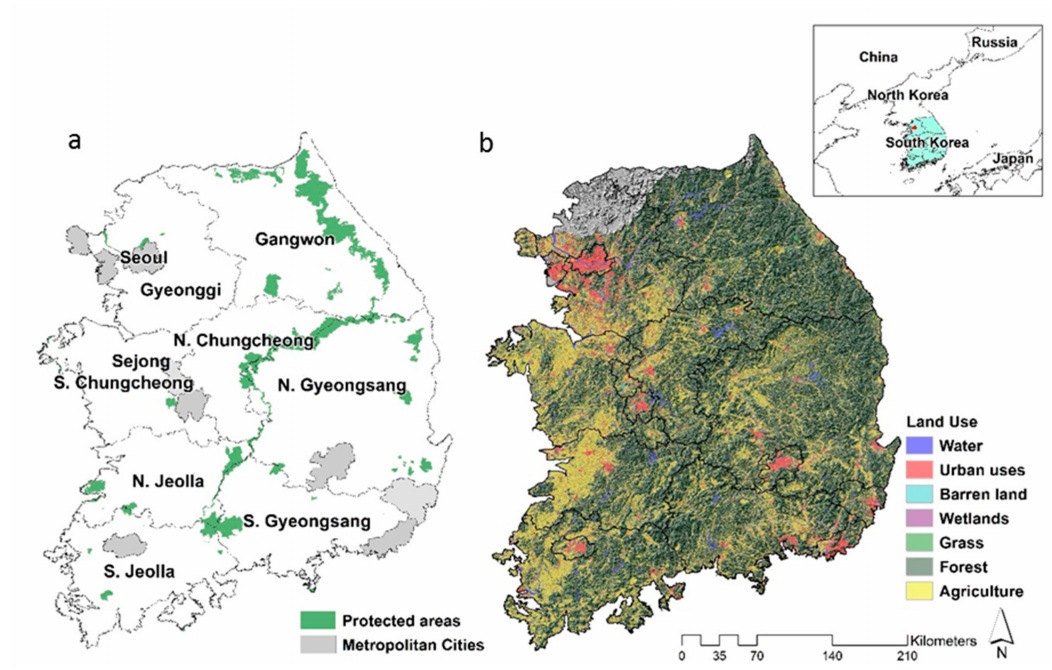
Figure 2. Distribution of the protected areas ( a ) and land use (2009) and topography of South Korea ( b ). Land use data for the northwest area is not available, so we excluded it from our